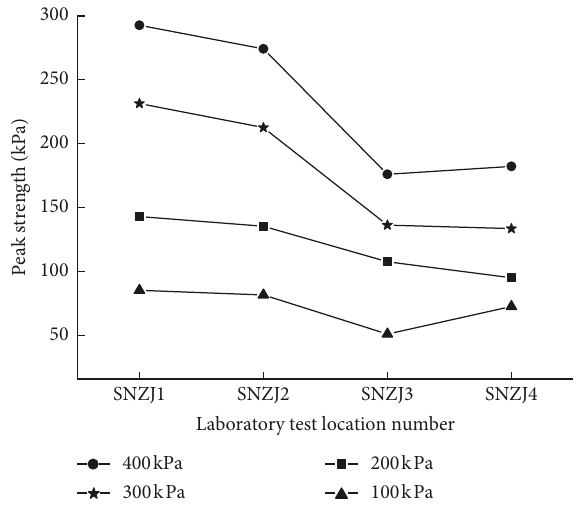
Figure 10: Variation of peak strength versus laboratory test location. Table 2: Cohesion and friction angle of the laboratory test.